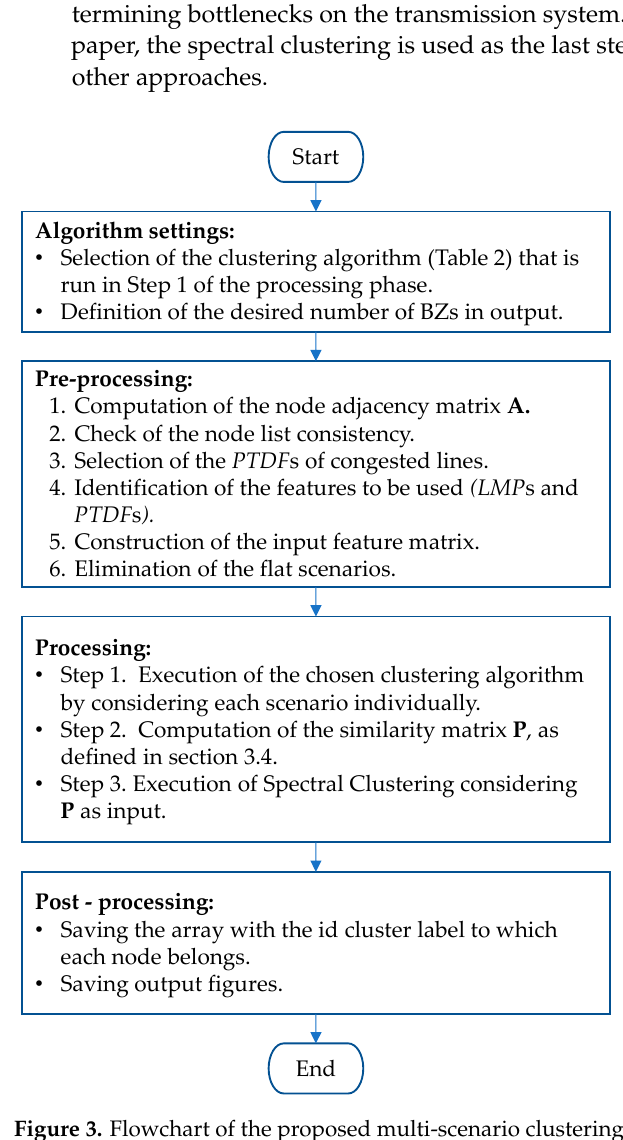
Figure 3. Flowchart of the proposed multi-scenario clustering methodology.